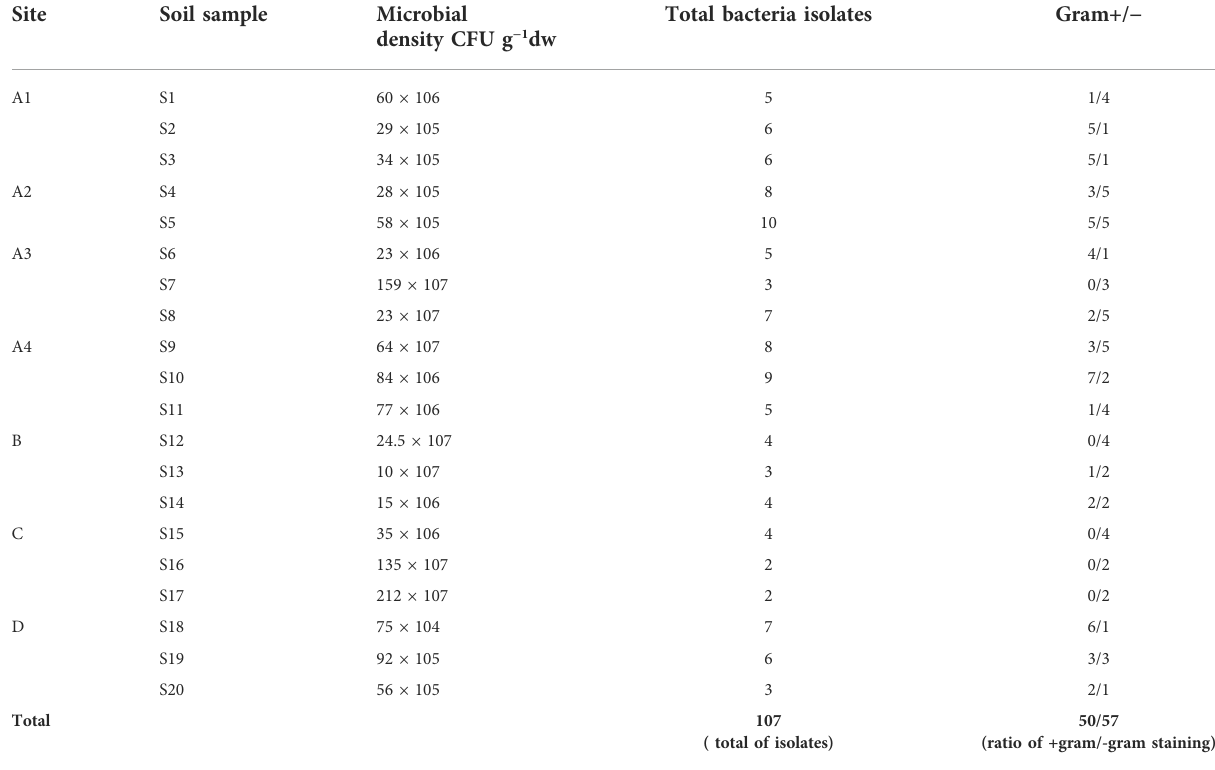
TABLE 1 CFU and Gram stain results of cultivable bacterial